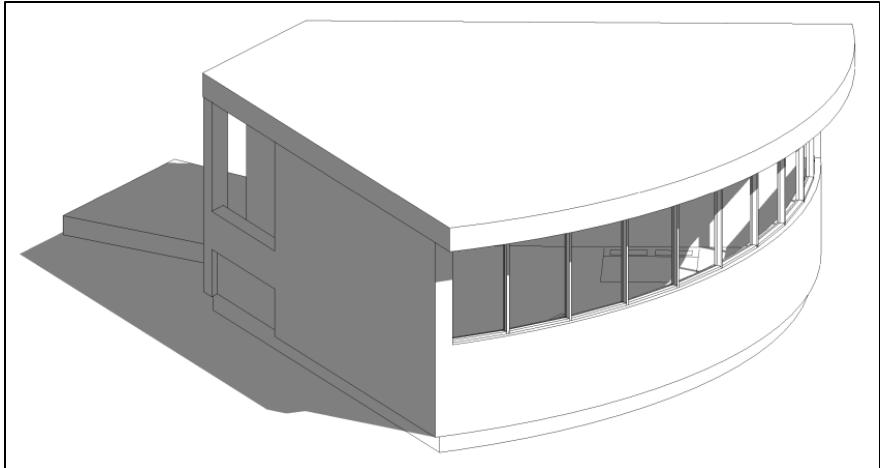
Figure 36. Typical residential unit. Lepenski Vir, Serbia (2019) by ArhiArhi (Predrag, Vladimir and Grigor Milošević) The residential unit in the tourist resort is to the maximum extent possible by the old design method used during the time of Lepenski Vir. It should not have gone further than 2 meters in height, for ecological and natural reasons (Figure 37). To provide surface ventilation, regulations on objects less than 2 meters should be kept. Since we need an internal height of at least 2.5 meters to live and stay for us to create a space that can be used, we had to bury a little bit of objects. It would not be difficult at this location, as the land is fragile. At the same time, this is how a problem of ventilation was solved, and the objects are not exposed to strong winds. Wind could greatly damage the structure if it was constantly hitting a 3-meter-high surface. Since there are all objects here only 1.5 meters above the ground, it can be said that the problem with the blows of the east wind, “košava”, is solved. Such shaped tourist units are more easily accepted by occasional bumps and wind blows (Figures 38 and 39).